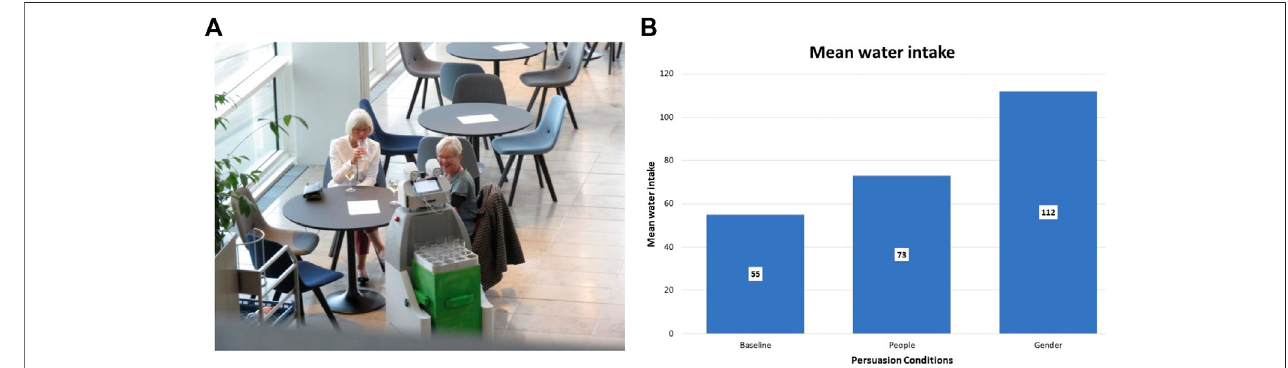
FIGURE 9 | Persuasive robot dialogue; (A) robot ’ s persuasive utterances successfully encourage members of the general public to drink more; (B) persuasive dialogue ( “ most participants ” or “ most female/male participants ” ) leads to signi fi cantly higher water intake.